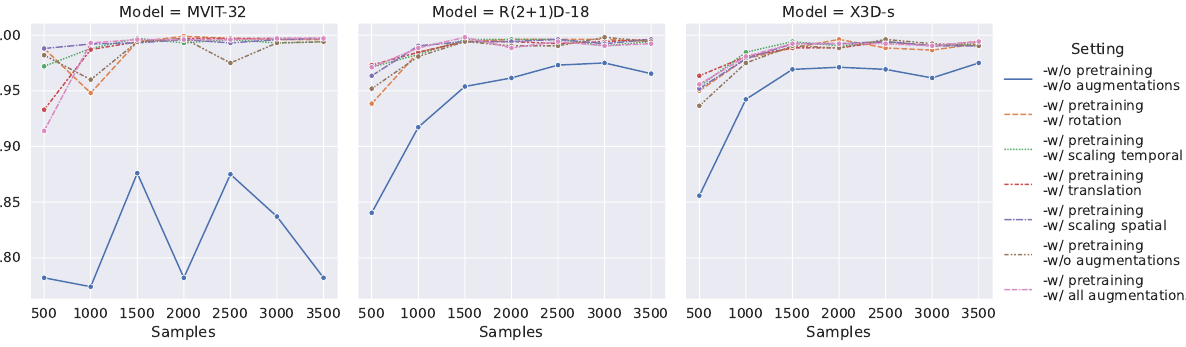
Figure 2. The F1 scores reported at the test set vs different number of samples used for training and validation with different model architectures and data augmentation